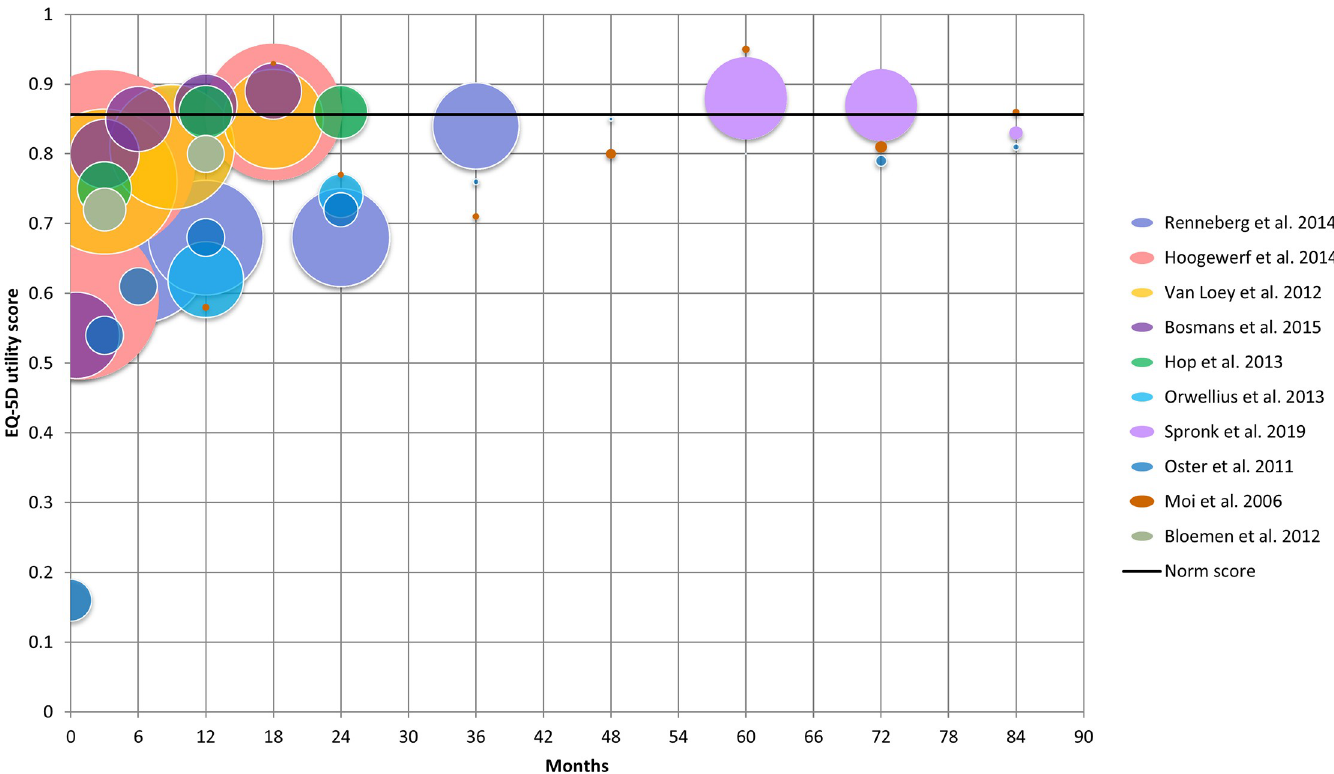
Fig 1. Raw outcomes of the different studies. The size of the bubble represents the number of outcomes within a study on a specific time point.